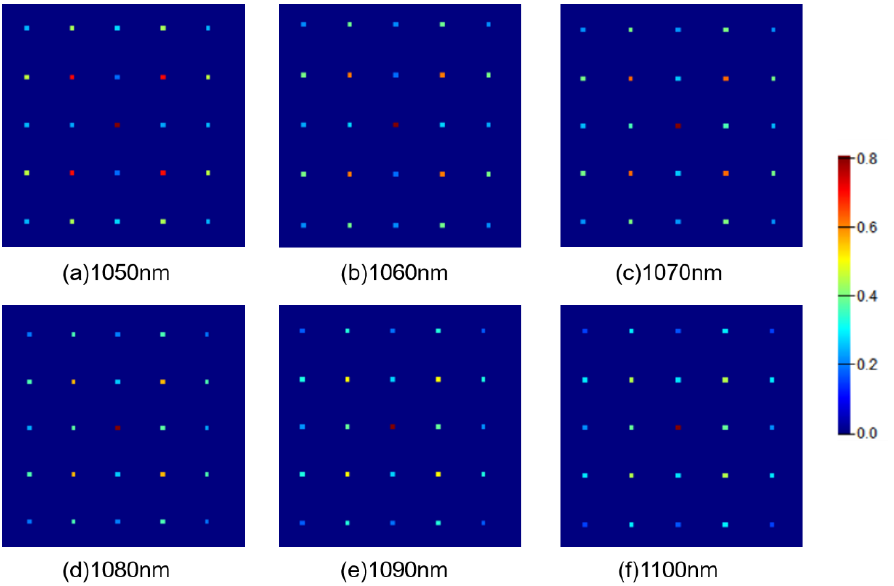
Figure 12. The conversion efficiency (red, y -axis on the left) and the contrast ratio (blue, y -axis on the right) of DG wavelengths from 950 nm to 1020 nm.